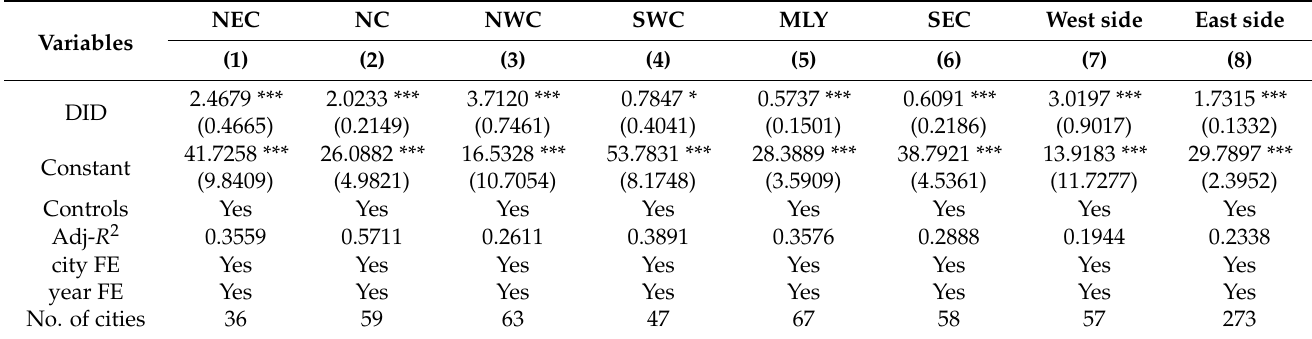
Table 6. Heterogeneity analysis: regional differences based on geographic space.